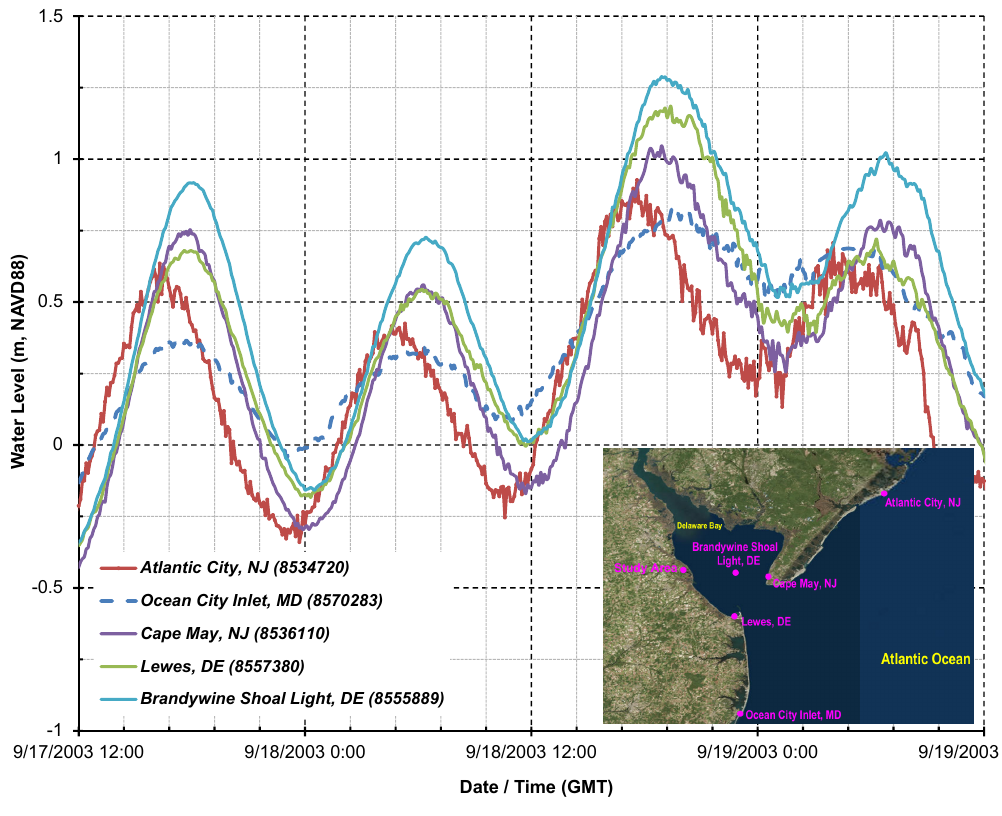
Figure 5. Observed water surface elevations during the passage of hurricane Isabel. For Hurricane Isabel track refer to Figure